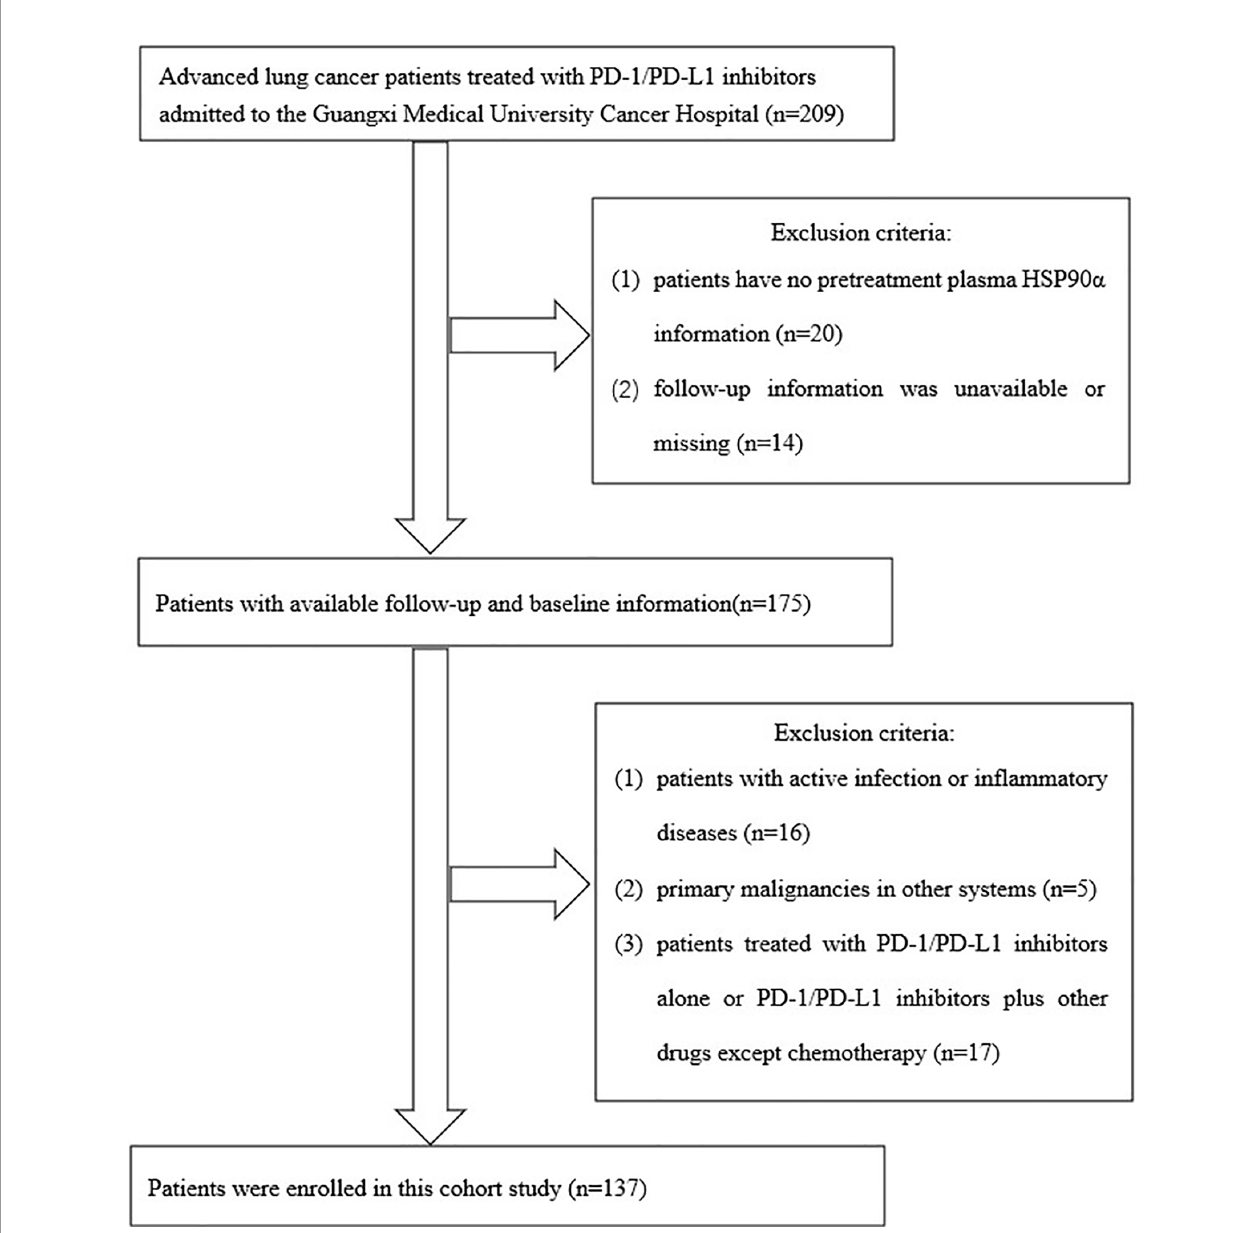
FIGURE 1 | Flowchart of the